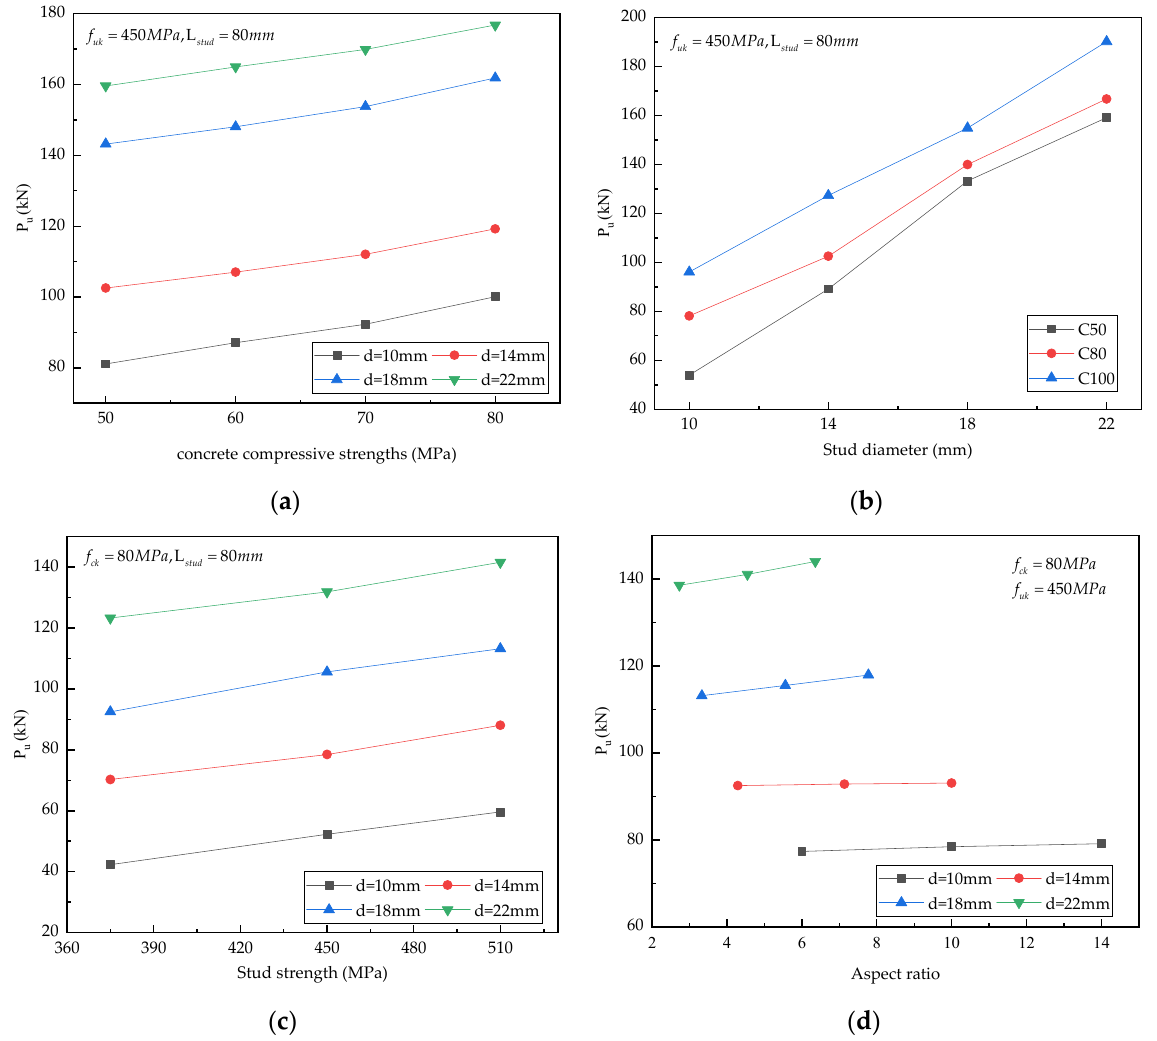
Figure 11. Parameter analysis: ( a ) concrete compressive strength; ( b ) stud diameter; ( c ) stud tensile strength; ( d ) stud aspect ratio. Note: d represents stud diameter; L stud represents stud length; f ck represents concrete compressive strength; f uk represents stud tensile strength.